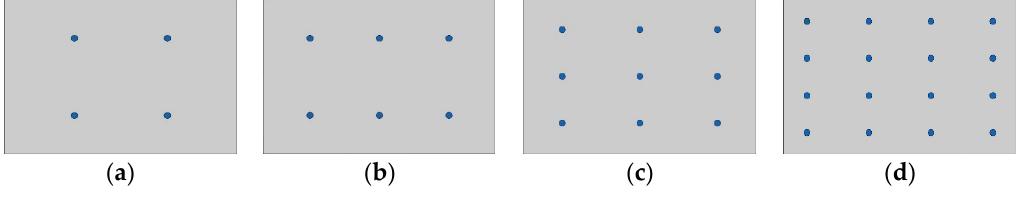
Figure 7. Calibration model: ( a ) four ‐ marker calibration model; ( b ) six ‐ marker calibration model; ( c ) nine ‐ marker calibration model; ( d ) 16 ‐ marker calibration model.